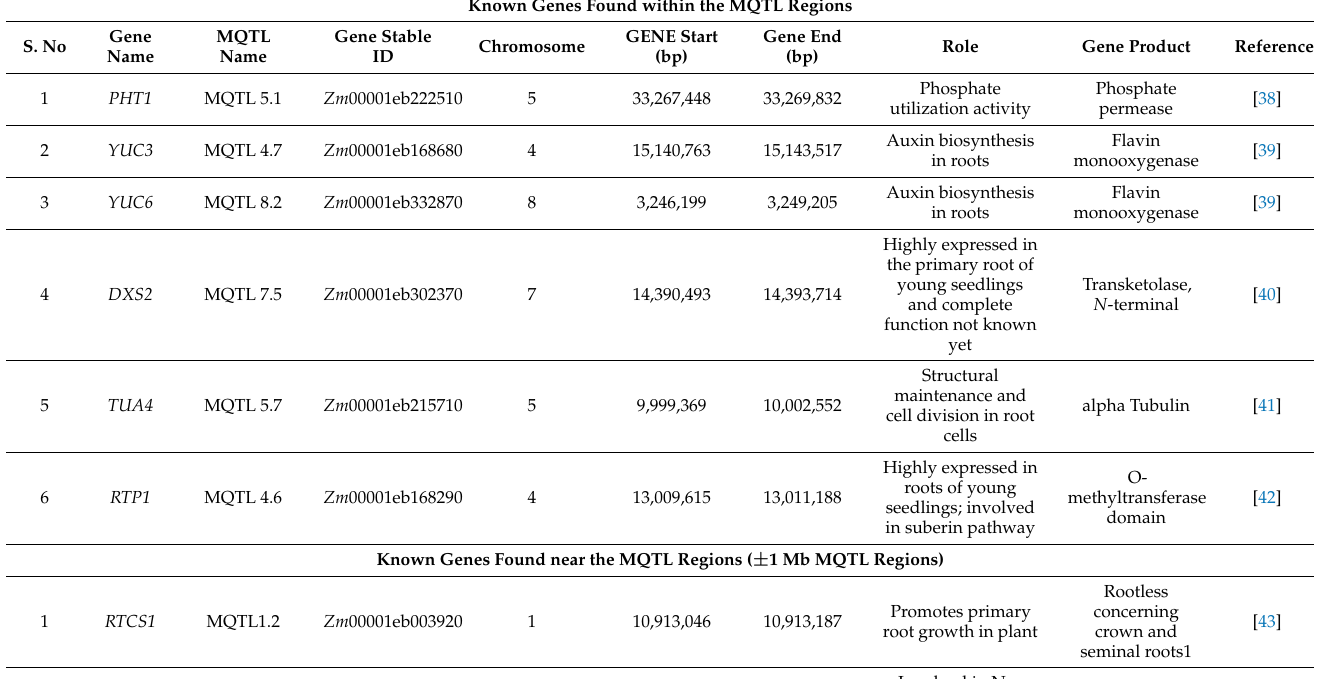
Table 2. Known maize genes co-localizing with different MQTLs identified during the present study. Known Genes Found within the MQTL